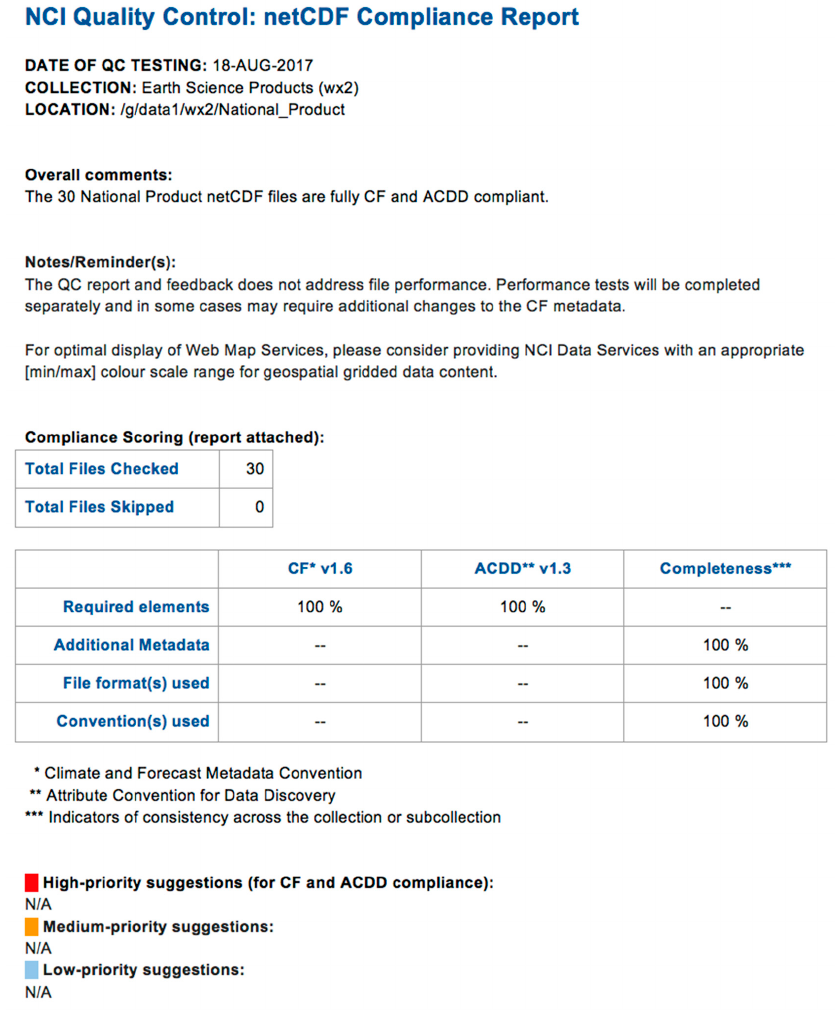
Figure A1. An example of NCI’s QC compliance report, which is shared with data producers and